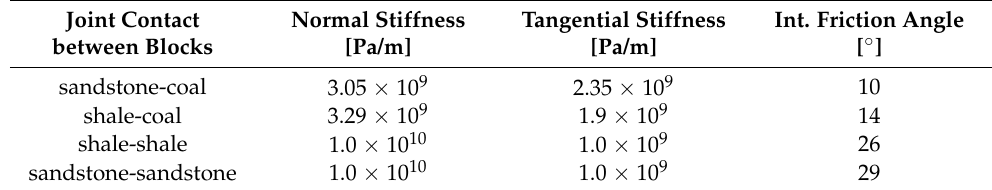
Table 3. Joint parameters adopted for calculations